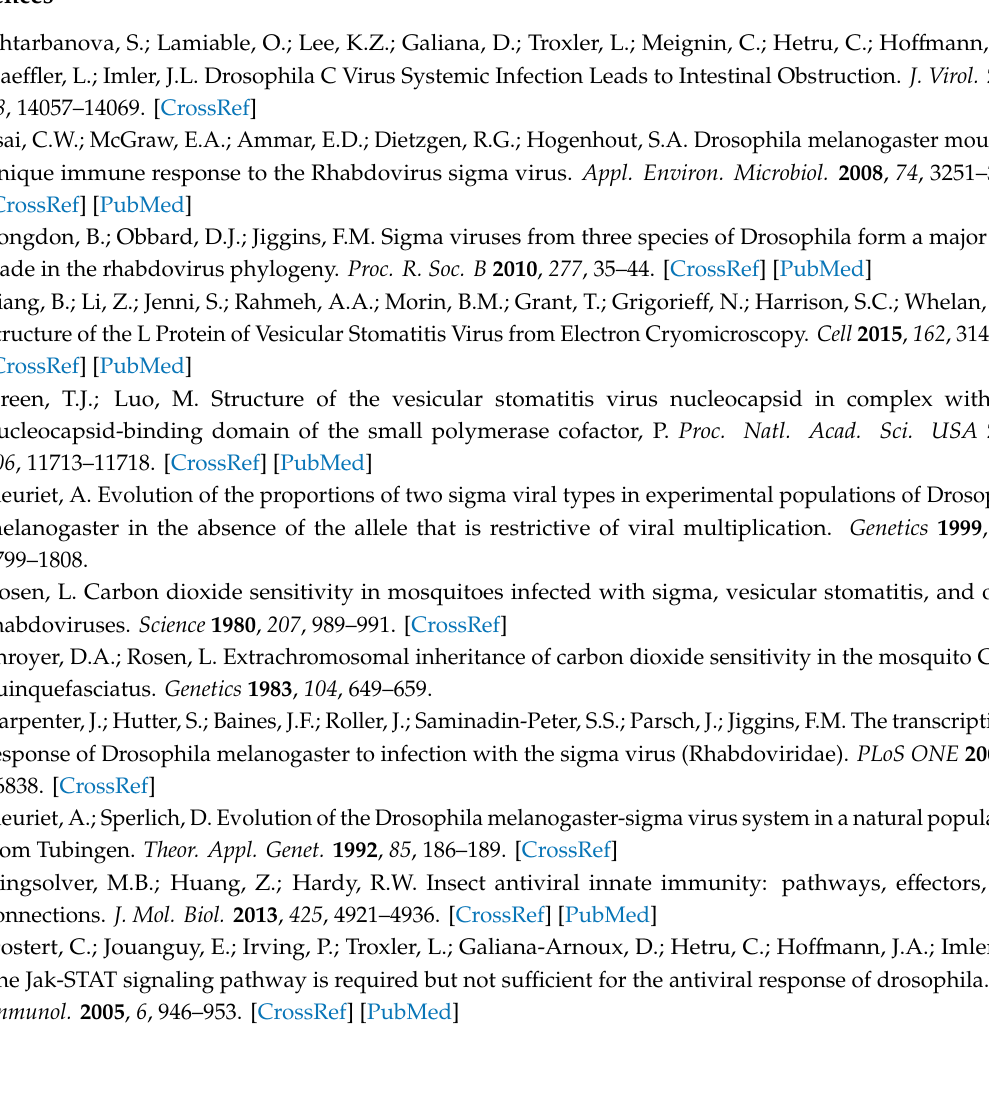
Figure S1: Gene expression of TBP increased after knocking down three upstream immune